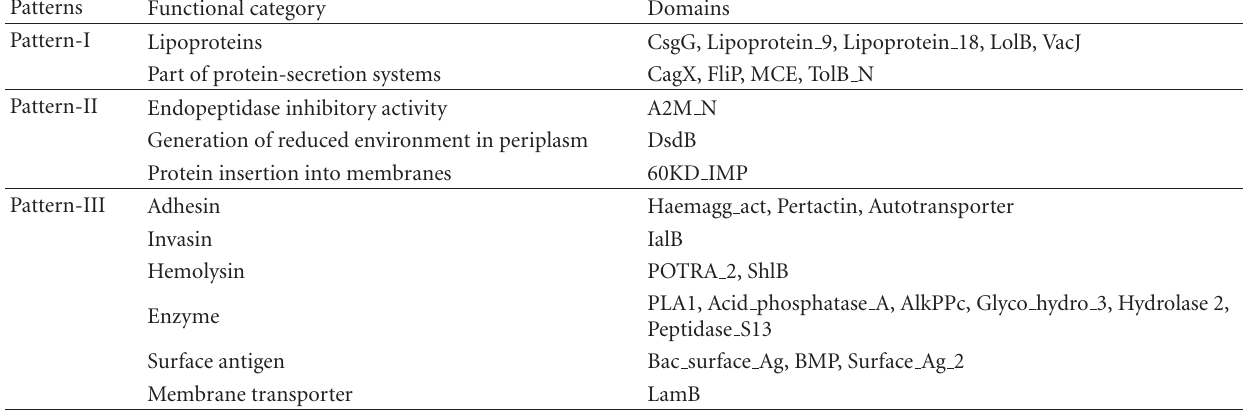
Table 2: Domain and functional groups associated with each cysteine-abundance and distribution-pattern detected in pathogenic and nonpathogenic Proteobacteria.